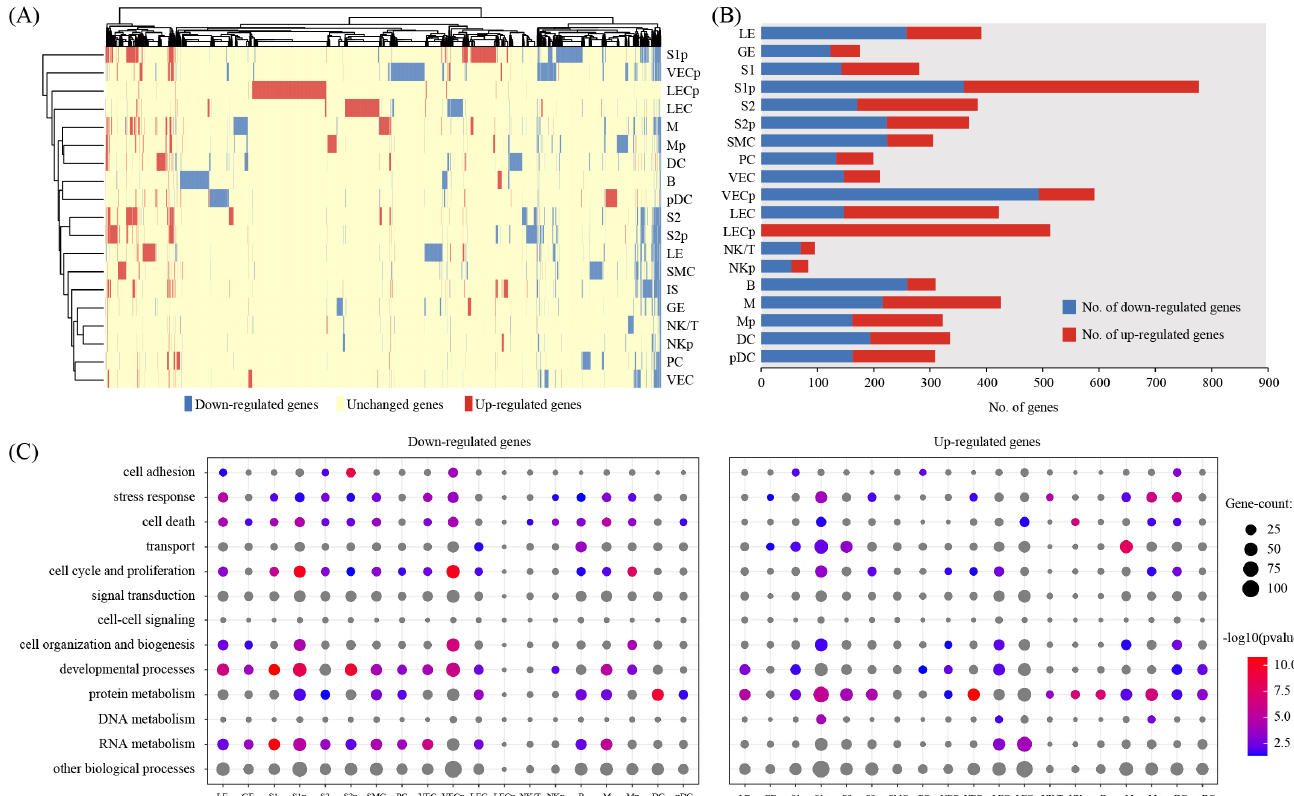
Figure 3. Gene expression changes in implantation sites compared to inter-implantation sites: ( A ) Heatmap showing the distribution of differentially expressed genes (logFC > 0.25 and p < 0.05) between implantation sites (IS) compared to inter-implantation sites (IIS) in each cell type; ( B ) the count of differentially expressed genes in each cell type; ( C ) gene ontology (GO) enrichment analysis of downregulated genes and upregulated genes, respectively. p < 0.05 was used as the significance cutoff. Non-significant hits ( p ≥ 0.05) are depicted in gray.